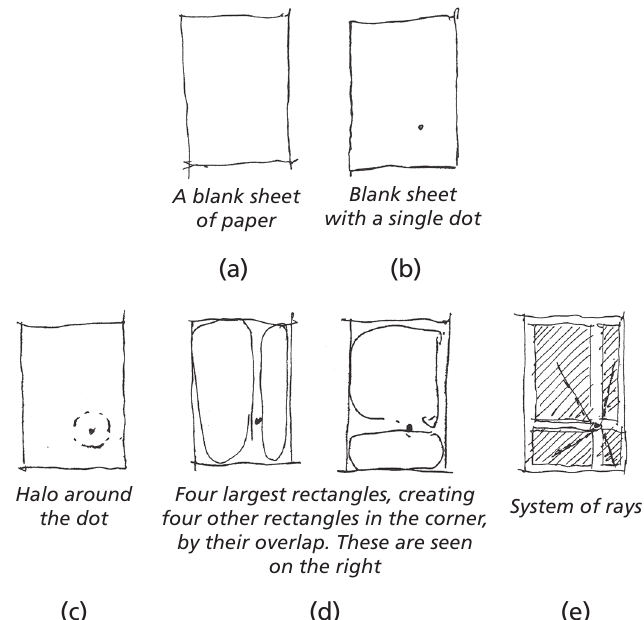
Figure 13. ( a ) a blank piece of paper; ( b ) the first center; ( c ) a halo around the dot; ( d ) four large latent rectangles; ( e ) a system of rays. Source: { Nature of Order Book One}